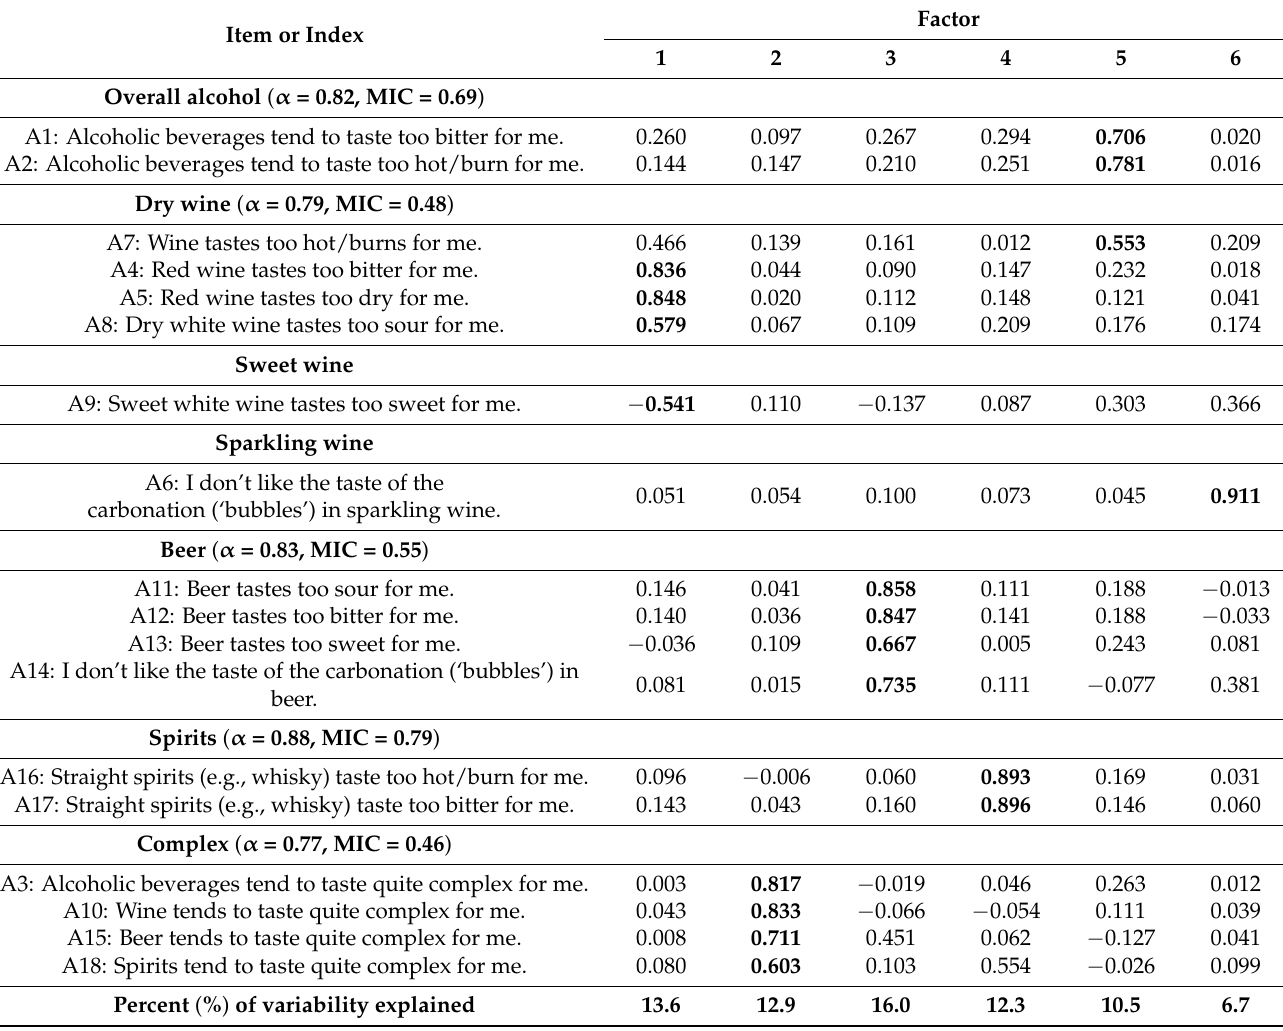
Table 1. Factor loadings for the principal component analysis of the alcohol taste statements after varimax rotation. Bolded values indicate on which factor each statement is most strongly loaded ( N = 925; MIC = mean interitem correlation, α = Cronbach’s